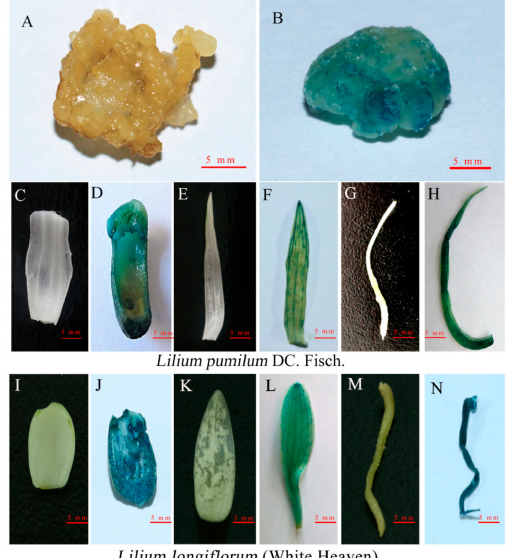
Figure 3. β -glucuronidase (GUS) histochemical assays of transgenic plants. A – H GUS histological staining results of Lilium pumilum DC. Fisch. A Untransformed embryogenic callus. B Transformed embryogenic callus. C – H show the scale, leaf, and root, respectively ( C , E and G are untransformed plant; D , F and H are transformed plant). I – N GUS histological staining results for the scale, leaf, and root of ‘White Heaven’ ( I , K and M are untransformed plant; J , L and N are transformed plant) (bars = 5